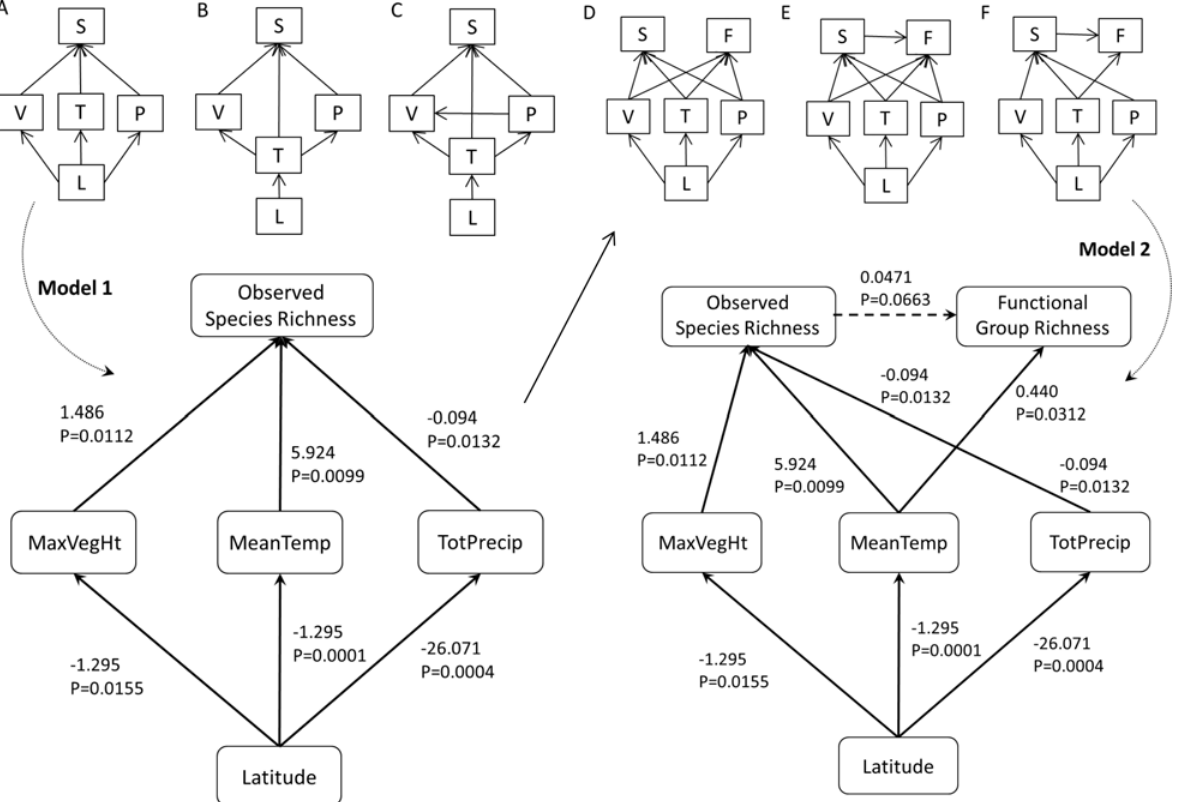
Fig 2. Three alternative (A, B, and C) directed acyclic graphs (DAG) of hypothesized direct and indirect effects on species richness (S). Model 1: results of best fit path model (derived from model A). D, E and F are alternative DAGs of hypothesized effects on functional group richness (F). Model: results of the best fit path model (from model F). The direction of the arrow indicates the direction of the relationship. Solid lines indicate a significant relationship. Estimated coefficients and P-values are shown for each relationship. Latitude (L), TotPrecip (P), MeanTemp (T) and MaxVegHt (V)